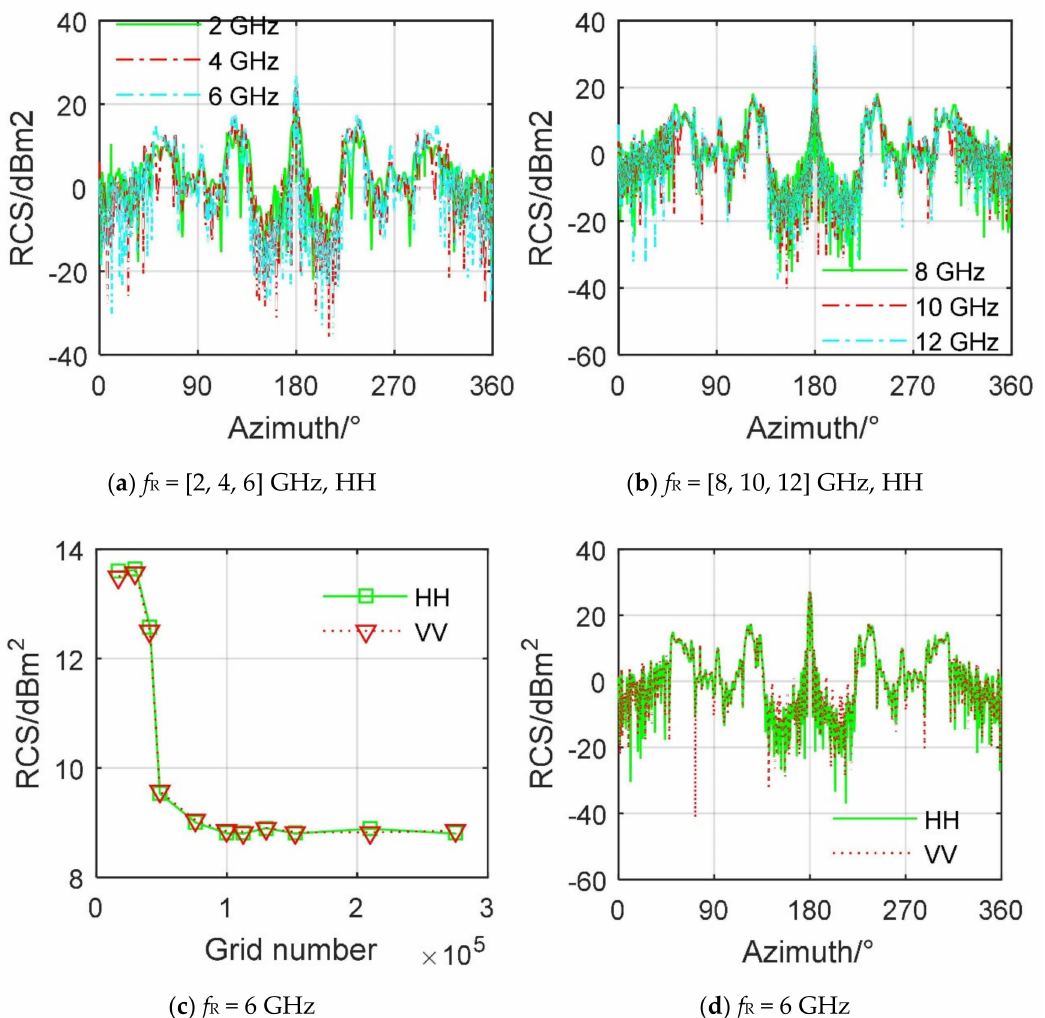
Figure A1. RCS algorithm test with m fan , α = 0~360 ◦ , β = 0 ◦ , and t = 1.25 × 10 − 4